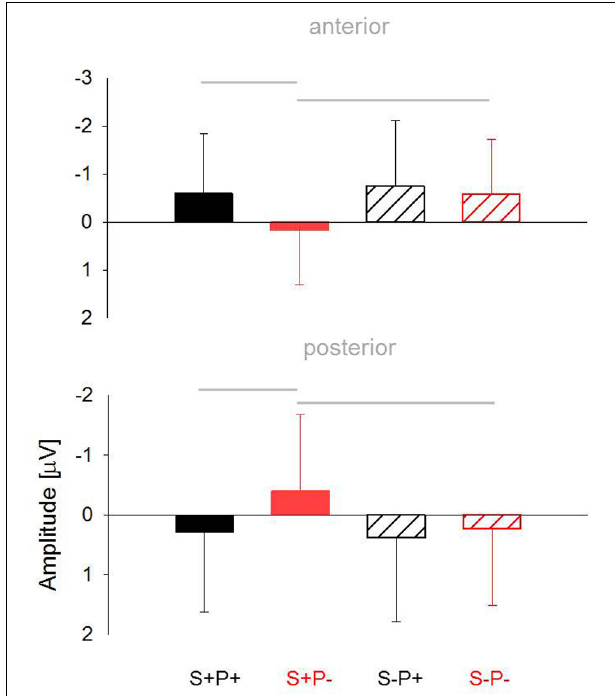
FIGURE 6 | Mean ERP-amplitudes between 300 and 400ms elicited for the anterior (upper panel) and posterior (lower panel) ROIs across all groups. Gray lines indicate significant differences between conditions, as revealed by post-hoc t -tests.